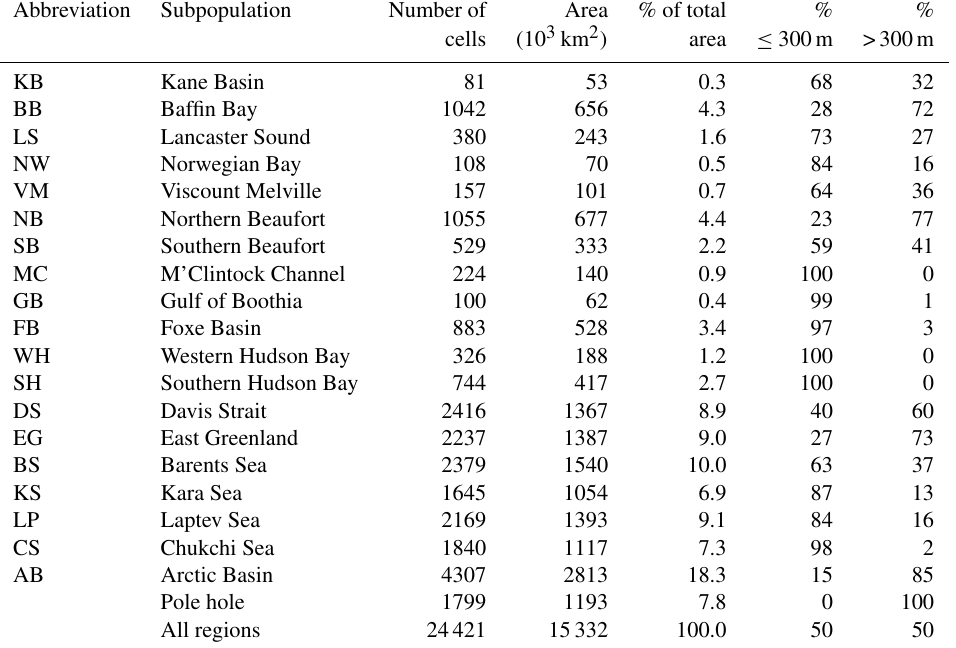
Table 1. Polar bear subpopulation region names, abbreviations, and areas. See Fig. 1 for a map of the regions. The area of each region includes the marine portion only, not land. The number of cells is the number of SSM/I grid cells. The percent of total area is with respect to all regions (last row). The percent of area shallower than 300m and deeper than 300m are given in the last two columns. The pole hole (second to last row) is the circular area around the North Pole excluded from analysis due to the satellite orbits. The Arctic Basin region (AB) surrounds the pole hole but does not include it. All regions includes all 19 subpopulation regions plus the pole